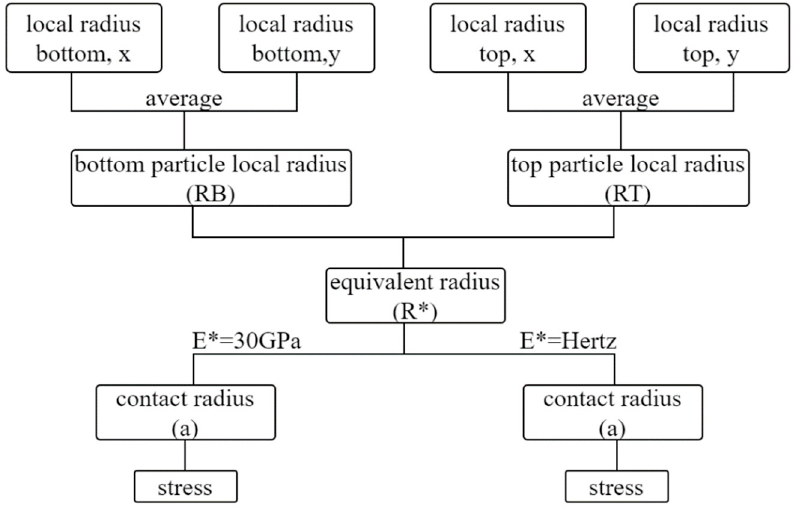
Figure 2. Flowchart of methodology in assessing the contact radius and stress at failure. Two orthogonally placed digital microscopic cameras were used to capture images of the top and bottom grains from two different directions (termed as “x” and “y” directions corresponding to the “yz” and “xz” planes, respectively, where “z” is the vertical axis). For each grain of the system (i.e., for the top and bottom grains), the arithmetic mean of the local radius as obtained from the two digital cameras was computed, termed as RB for the bottom grain and RT for the top grain, based on Equation (1a) and (1b), respectively. Subsequently, applying the Hertz model, the equivalent radius ( R* ) was estimated based on Equation (2), and the contact radius ( α ) was calculated from Equation (3). Based on the estimated contact radius, the stress at failure was calculated based on Equation (4), where F d is the vertical force at failure (note that a discussion on the failure force through representative force–displacement curves from the experiments is presented in Section 3.5).